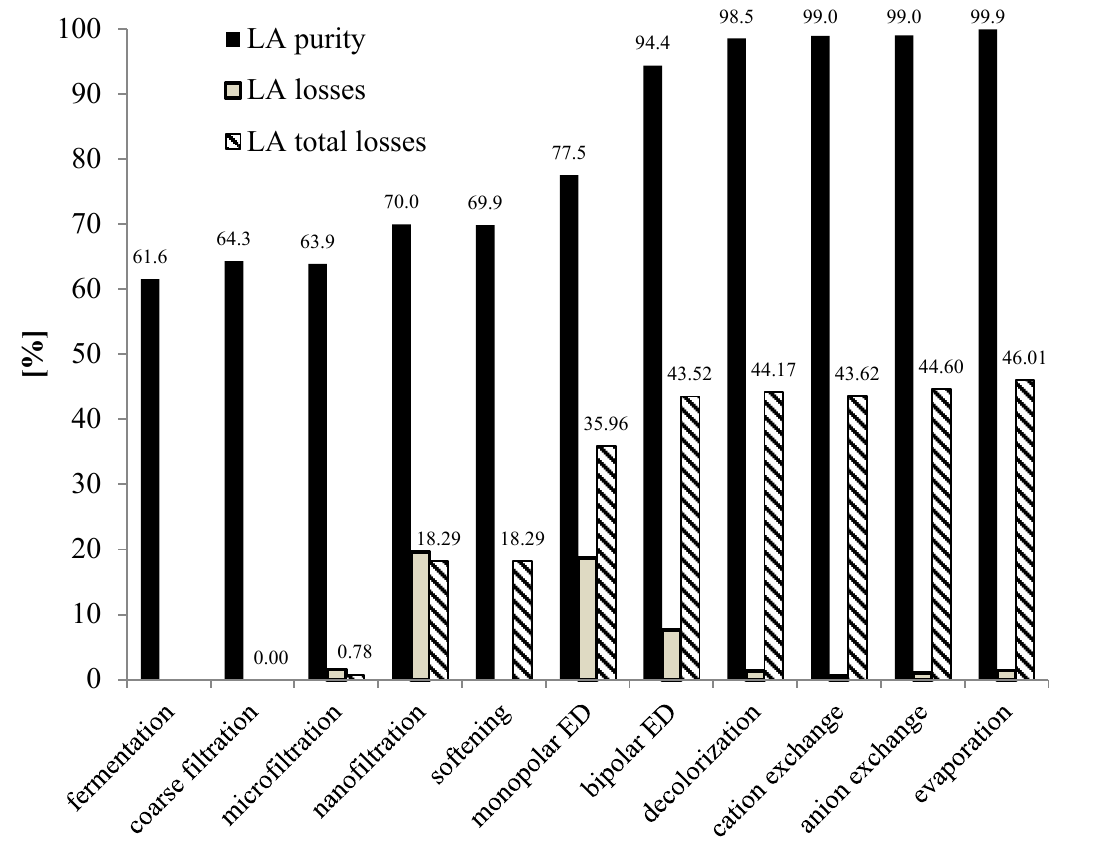
Figure 5. Average purity of lactic acid, accumulative total losses (%) after every step of the downstream process of the two pilot scales of the carob bagasse fermentation with 30% solids.